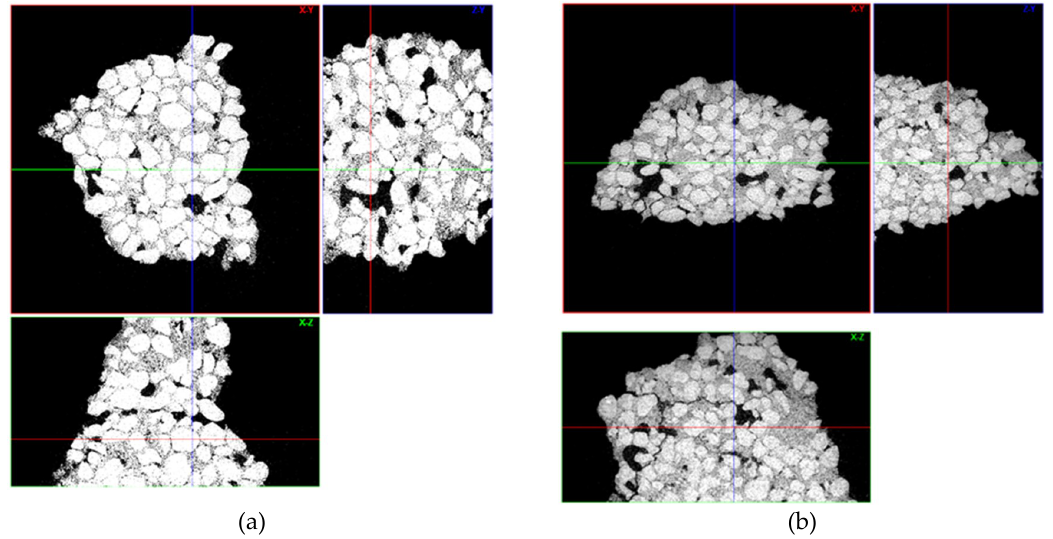
Figure 11. Ceramic mold sample tomograms heated at 950 °C, showing three cross-sections in the XY, YZ, and XZ planes for: ( a ) Sample Q1 and ( b ) Sample Q2.